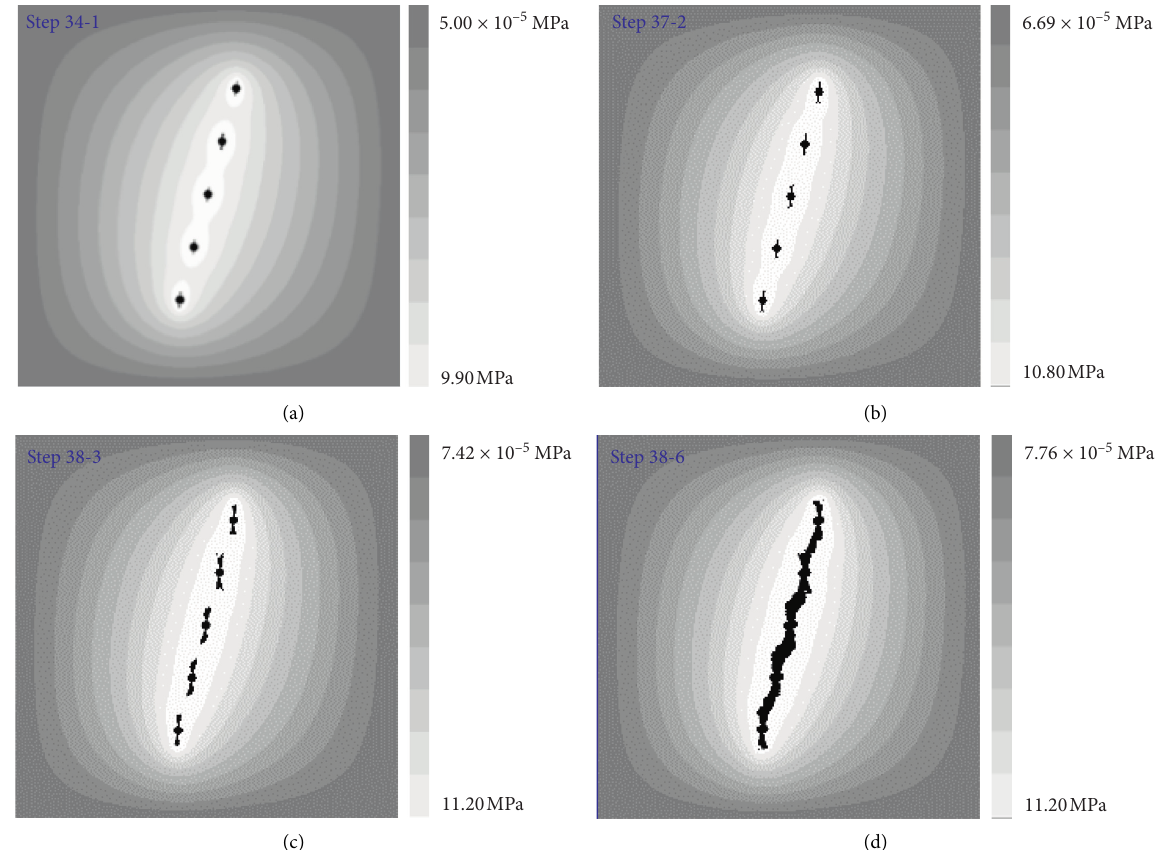
Figure 7: The variation of water pressure contour during hydraulic fracturing.